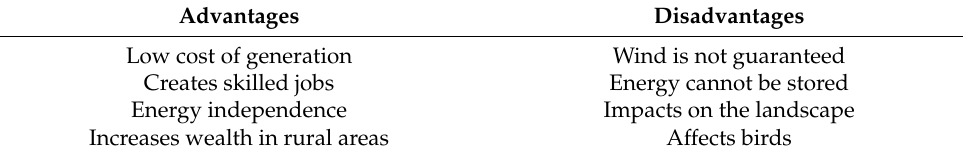
Table 7. Advantages and disadvantages of wind energy.